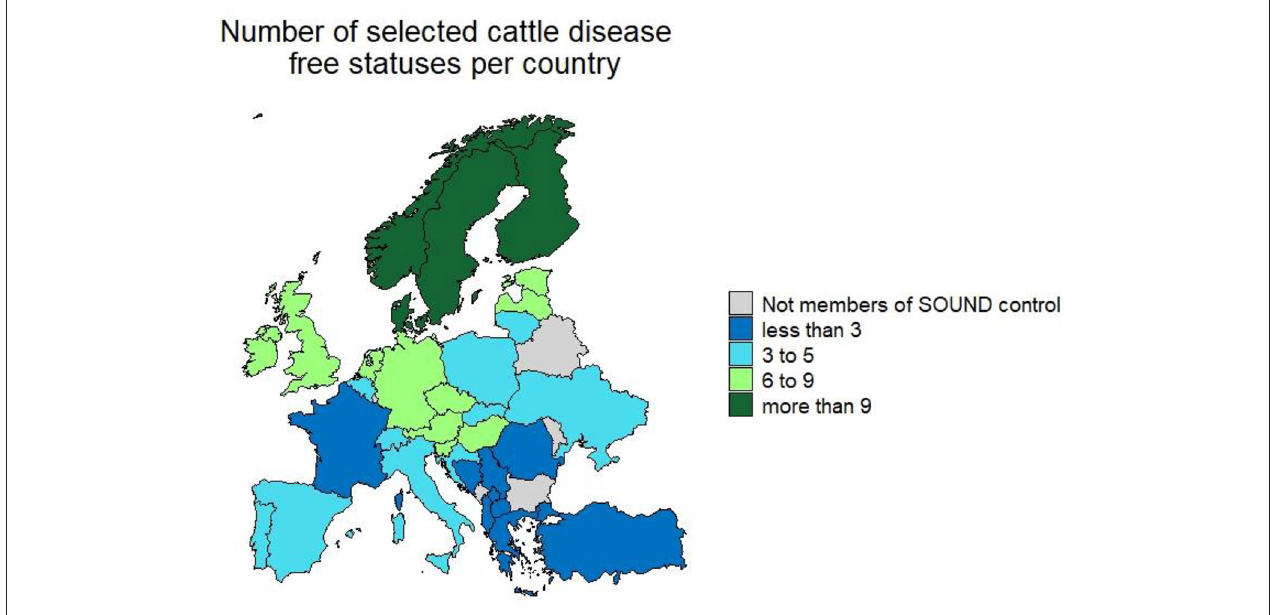
FIGURE 3 | Number of selected cattle disease-free statuses in countries participating in Standardising output-based surveillance to control non-regulated diseases of cattle in the European Union (SOUND control).